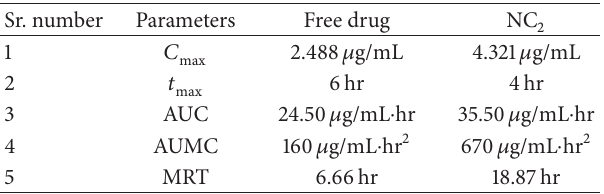
Table 6: Pharmacokinetic parameter of drug determined after administered of plain drug and niosomal formulation. Sr.